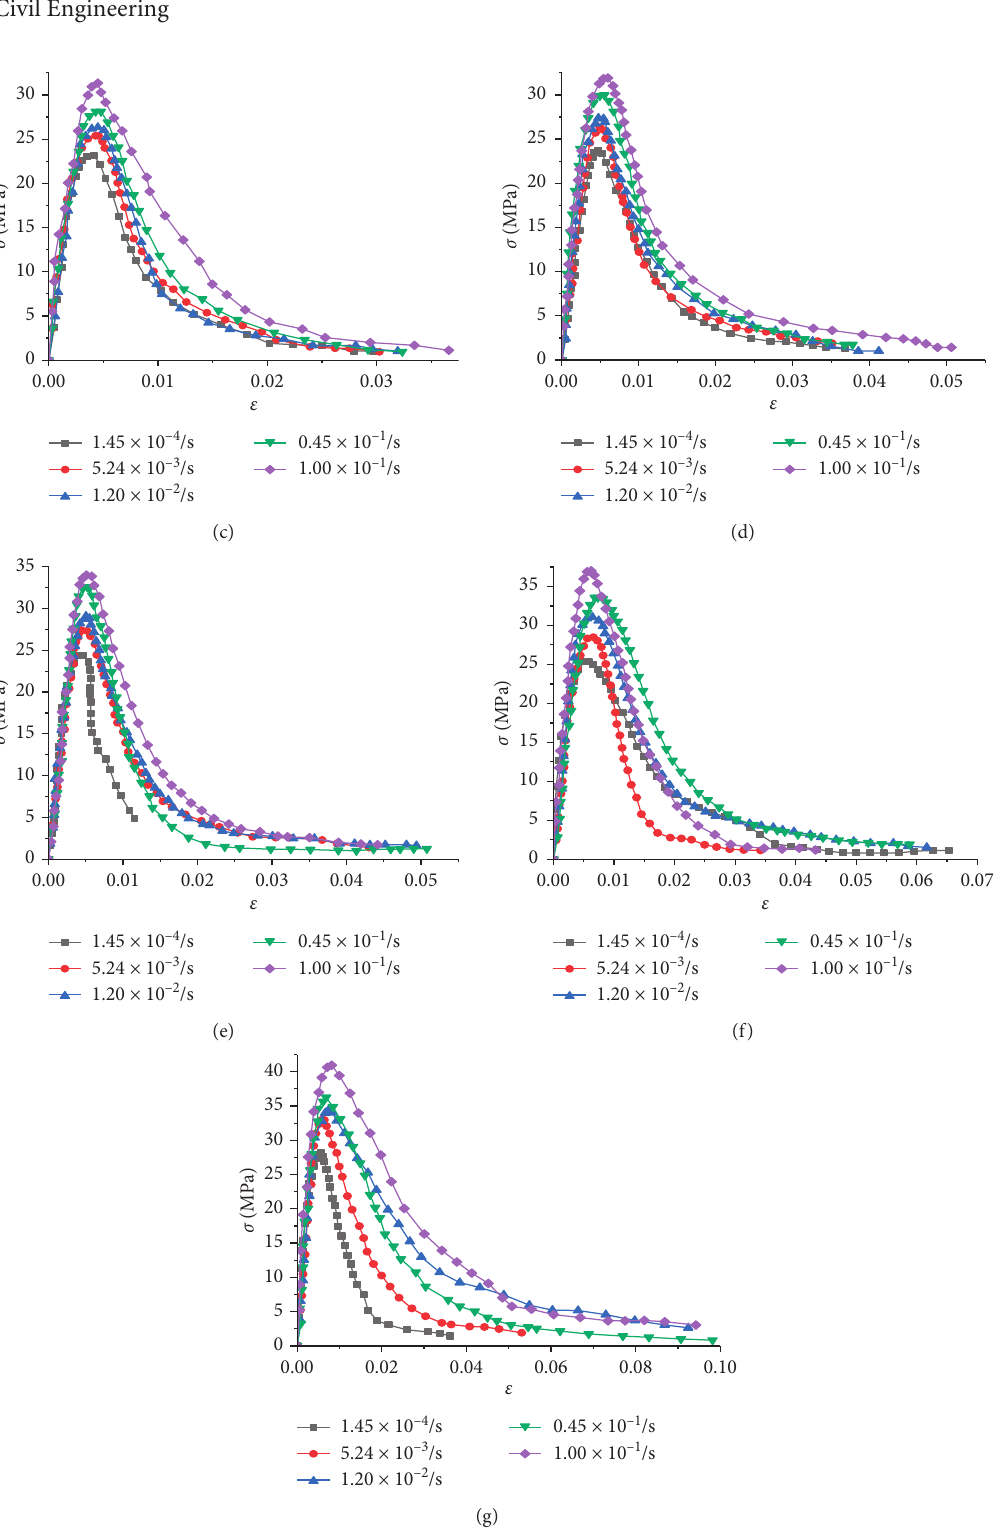
Figure 5: The dynamic compressive stress-strain curves of concrete specimens under different strain rates: (a) plain concrete; (b) PFRC with V f � 0.067%; (c) PFRC with V f � 0.1%; (d) PFRC with V f � 0.133%; (e) SFRC with V f � 0.75%; (f) SFRC with V f � 1.0%; (g) SFRC with V f �